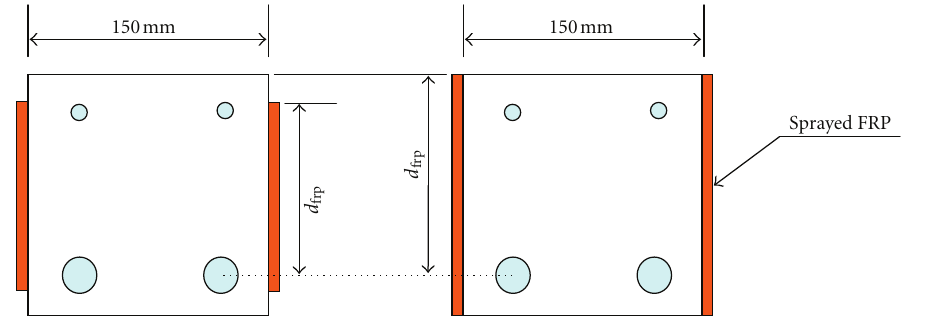
Figure 38: Depth of FRP Shear Reinforcement.